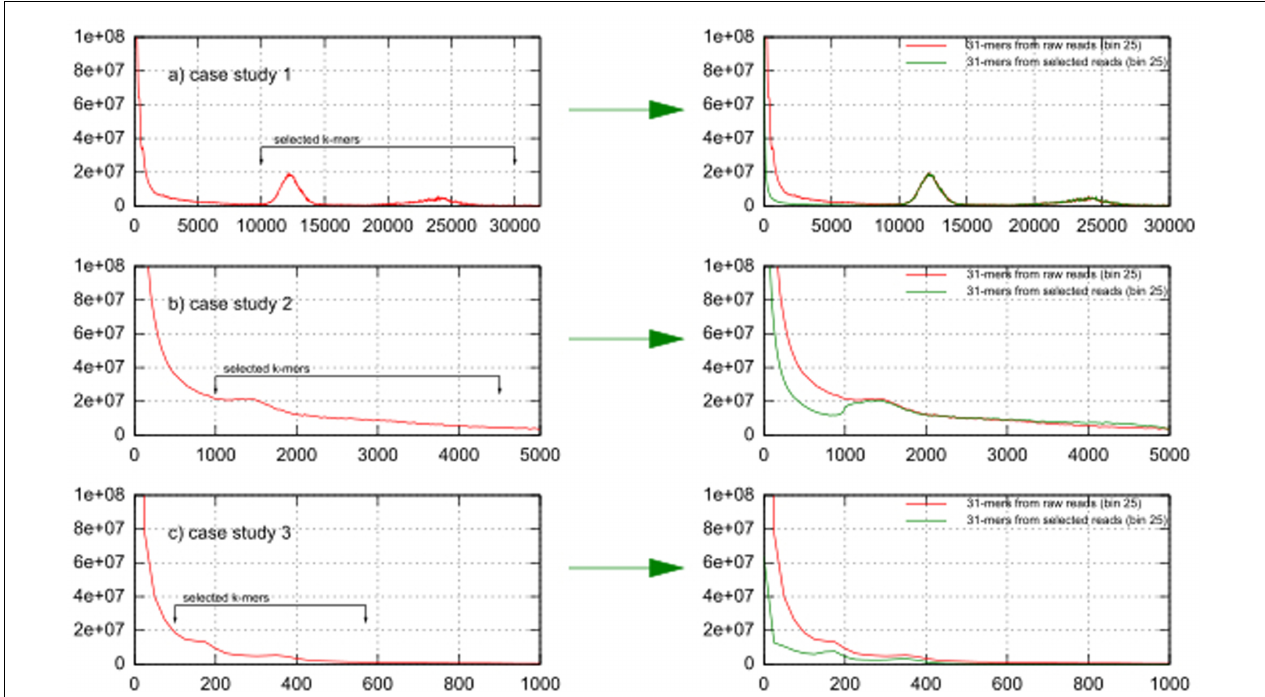
FIGURE 2 | K -mer frequencies distribution of case studies 1, 2, and 3 before and after the k -mer selection. (a) In case study 1 (tomato) the nuclear haploid genome size is 950 Mbp, (b) in case study 2 ( Aegilops tauschii ) it is 4–5 Gbp, (c) in case study 3 ( Paphiopedilum henryanum ) it is 25–35 Gbp.